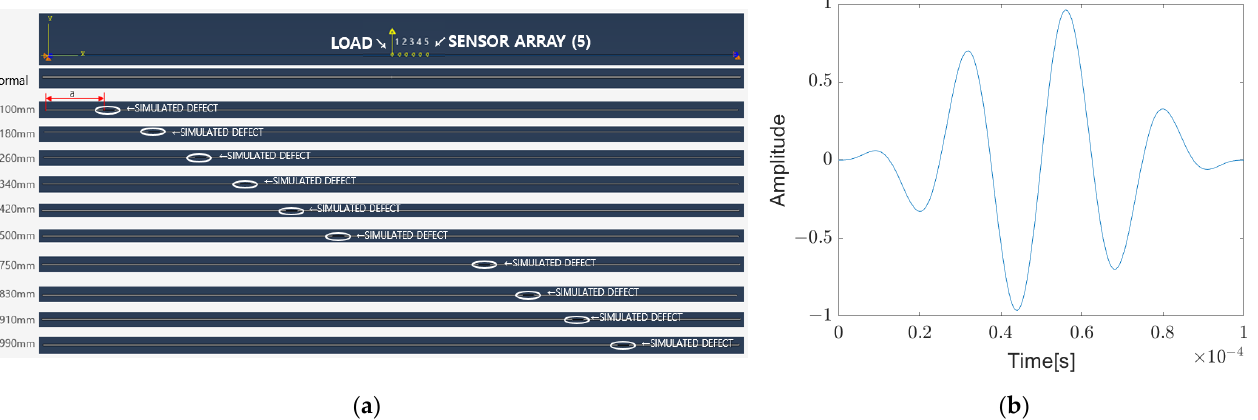
Figure 2. ( a ) Simulated 2D aluminum panels with defect; ( b ) Excitation signal with center frequency of 40 kHz.